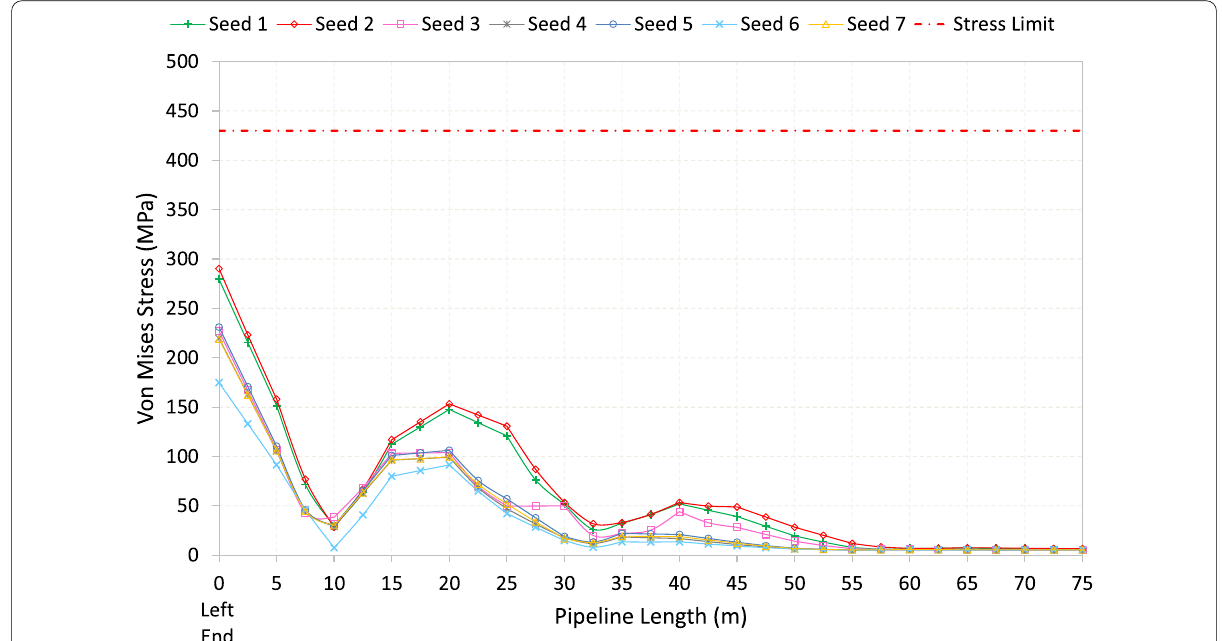
Fig. 15 Envelopes of the von Mises stresses of the pipeline for the seven simulations